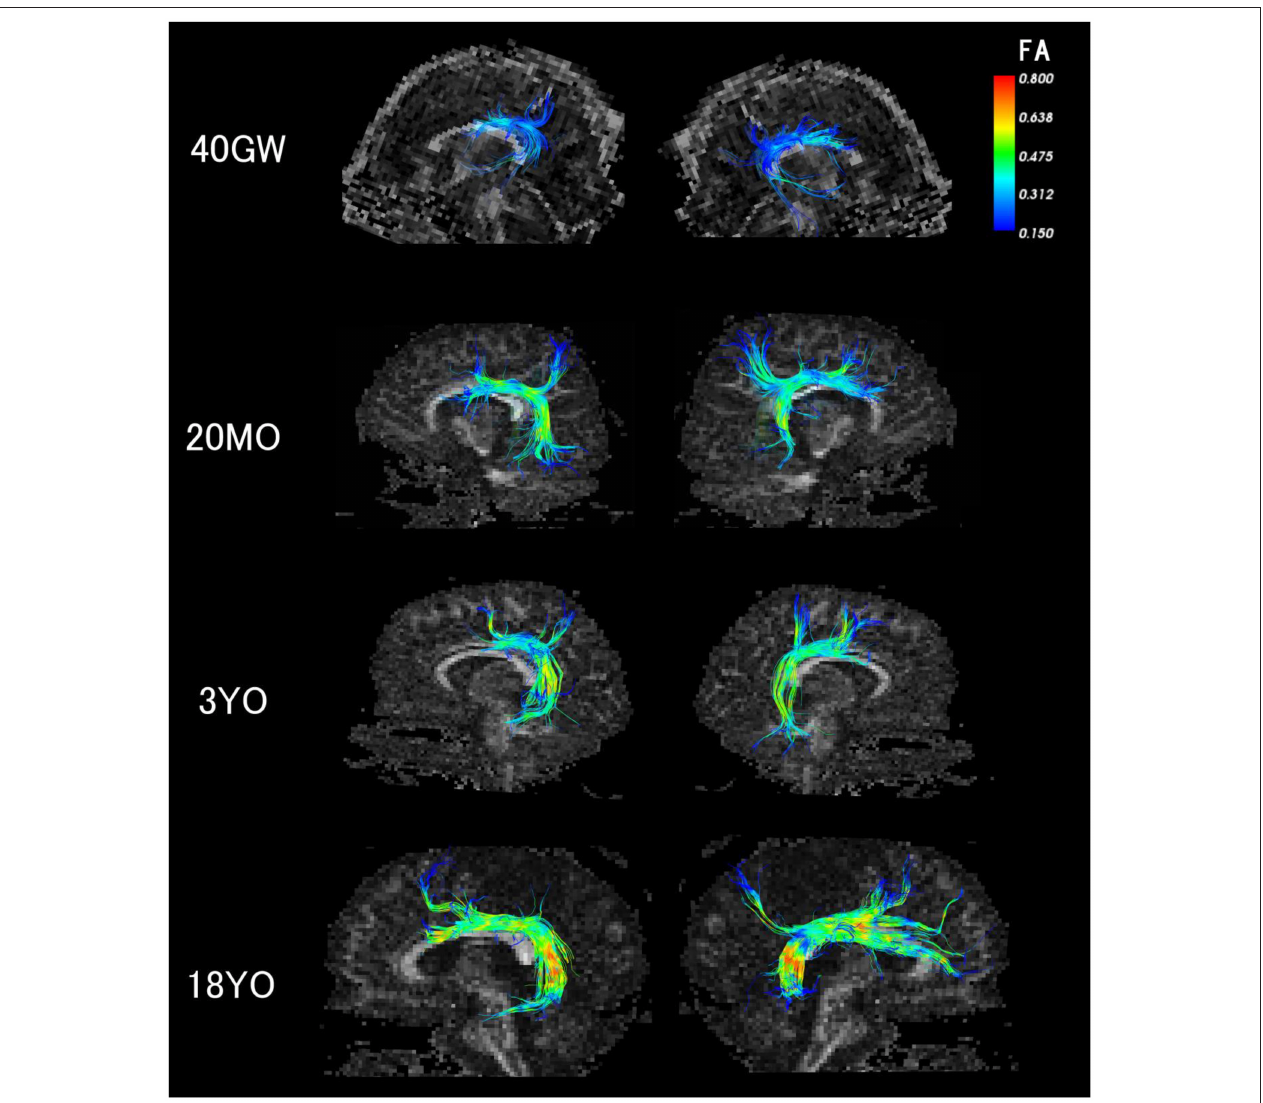
FIGURE 4 | Color-corded FA values on detected AF pathways in 40 gestational weeks, 20 months old, 3 years old, and 18 years old subjects. The color coding of fibers is based on FA